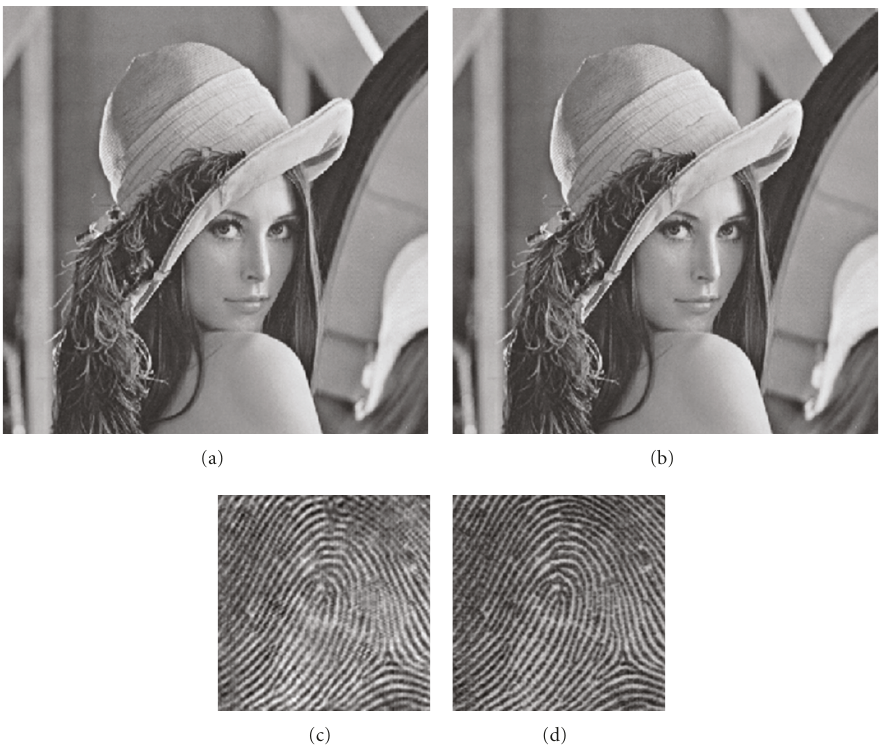
Figure 8: (a) Lena image. (b) Watermarked image. (c) Original watermark. (d) Extracted watermark.